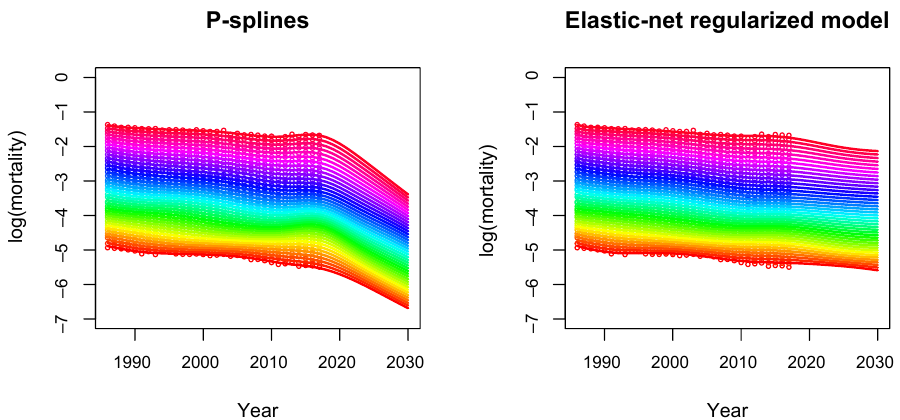
Figure 7. Logarithm of the fitted death rates and forecast death rates for France by ages (50–90) over years (1986–2030) after a pandemic shock in 2013, followed by a continuous mortality increase. On the left : forecast by the P-spline model. On the right : forecast by our regularized elastic-net